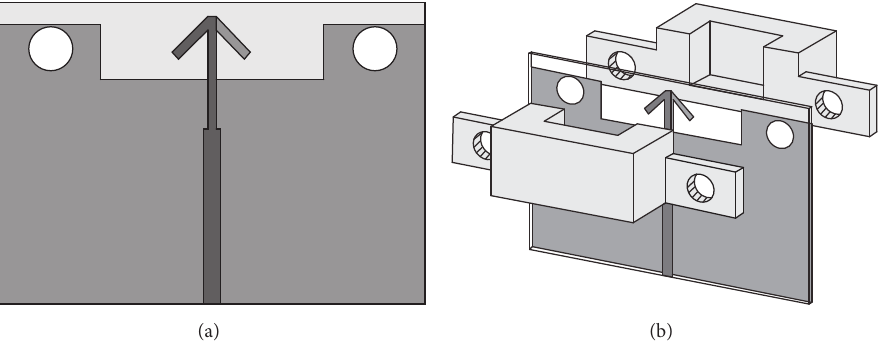
Figure 32: A cavity-backed angled-dipole antenna [99]. Front view (a) and tridimensional view (b). The flanged cavity is observable in the figure. Dark gray upper metal face, medium gray bottom metal face, and light gray dielectric substrate.